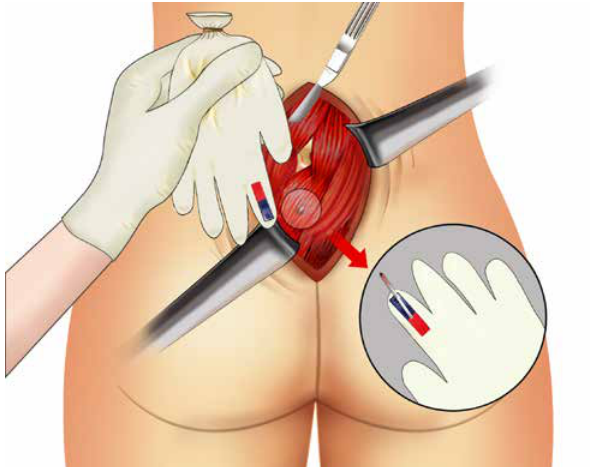
Figure 3: Schematic diagram of operation process was shown in Figure